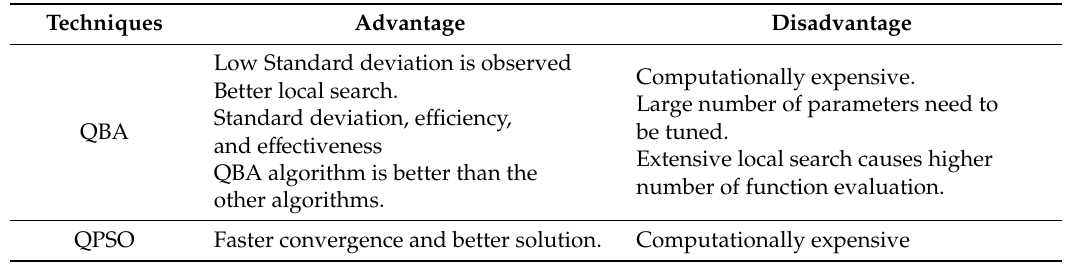
Table 3. Economic parameters used by authors in well placement